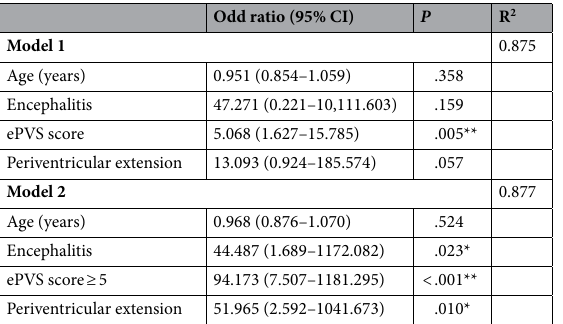
Table 2. Logistic regression models for poor 6-month outcomes. ePVS enlarged perivascular space. * P < .05 and ** P < .01.